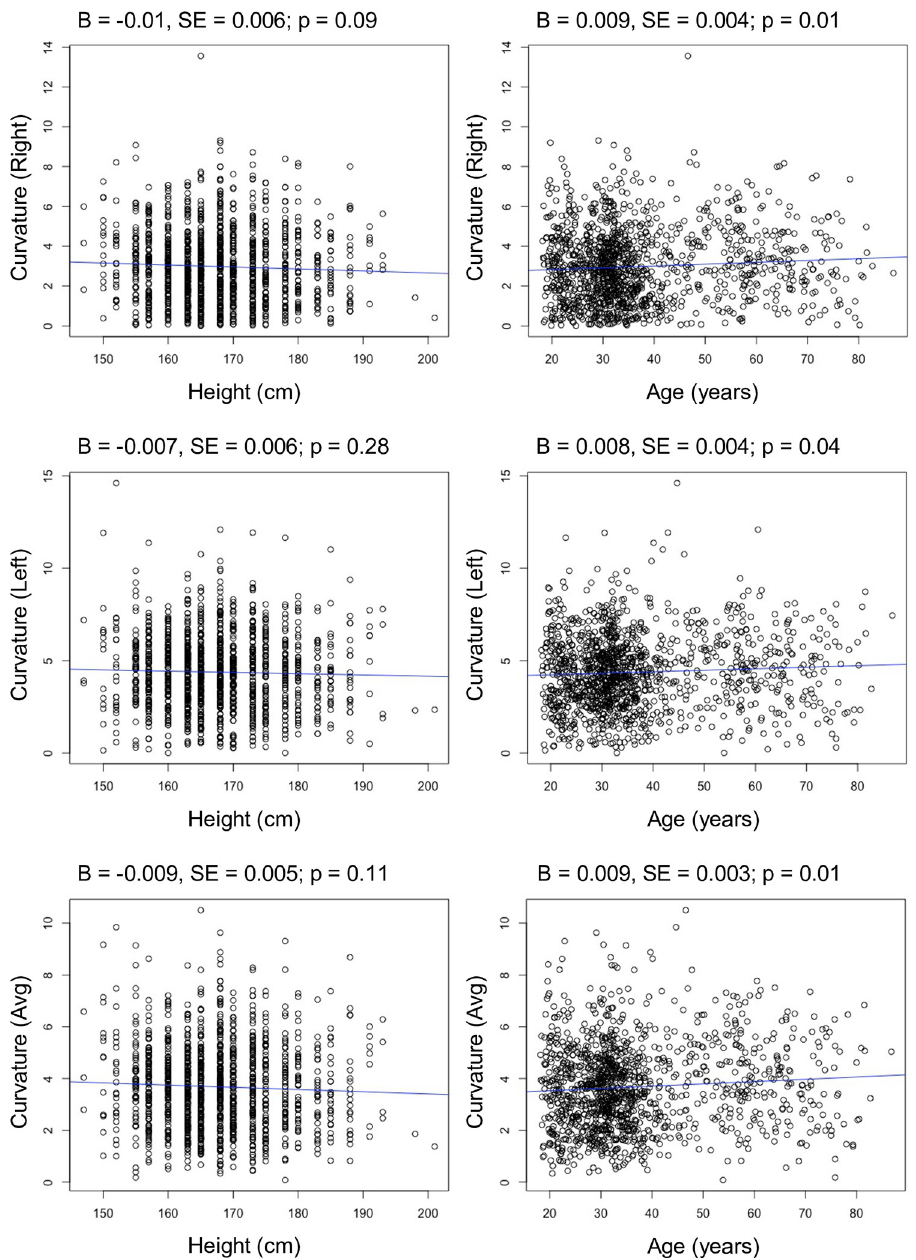
Fig 3. Regression results showing the relationship between height and age with fifth finger curvature. Regression statistics are included at the top edge of each chart: B = unstandardized regression coefficient; SE = standard error of B; p = p-value from test of whether the observed regression coefficient is different from